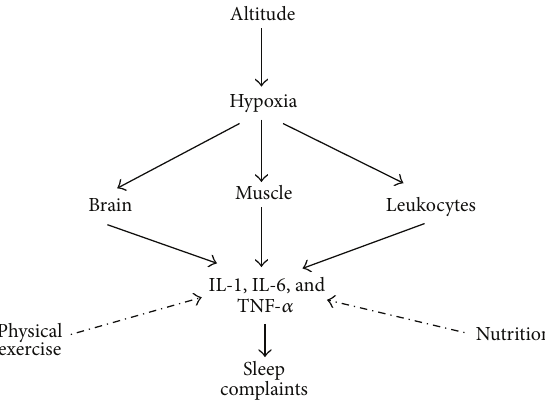
Figure 1: Solid line indicates stimulation; dotted line indicates